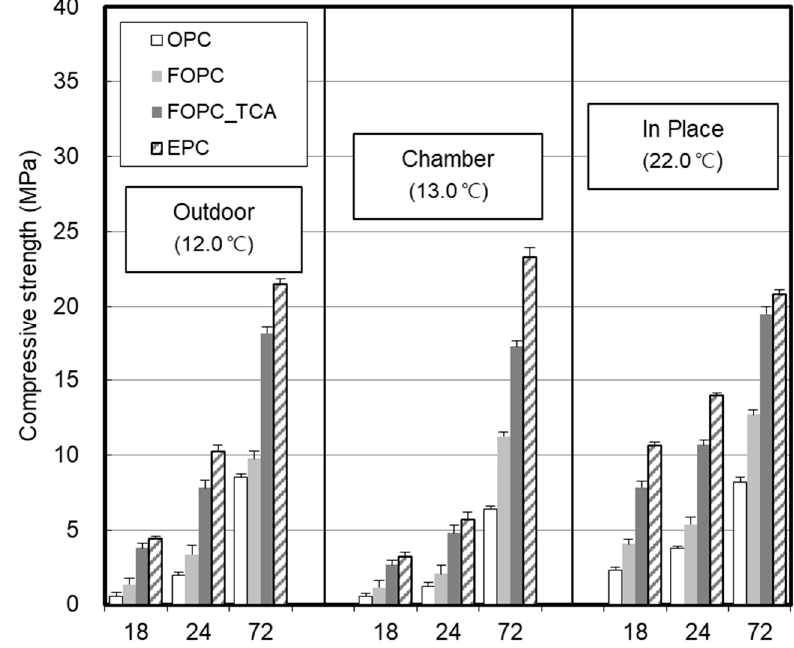
Figure 6. Early compressive strength development in concrete with time.